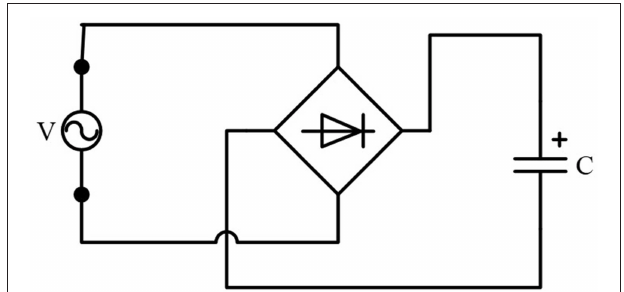
FIGURE 4 | The energy harvester circuit diagram.